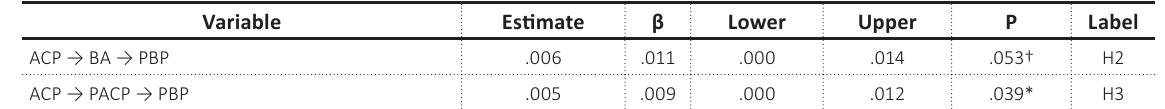
Table 4. Mediating